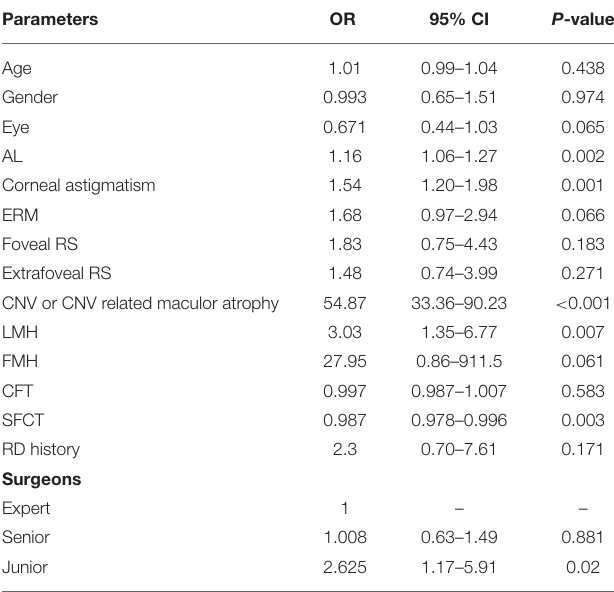
TABLE 5 | Logistic regression model of post-operative low vision in highly myopic cataract eyes.